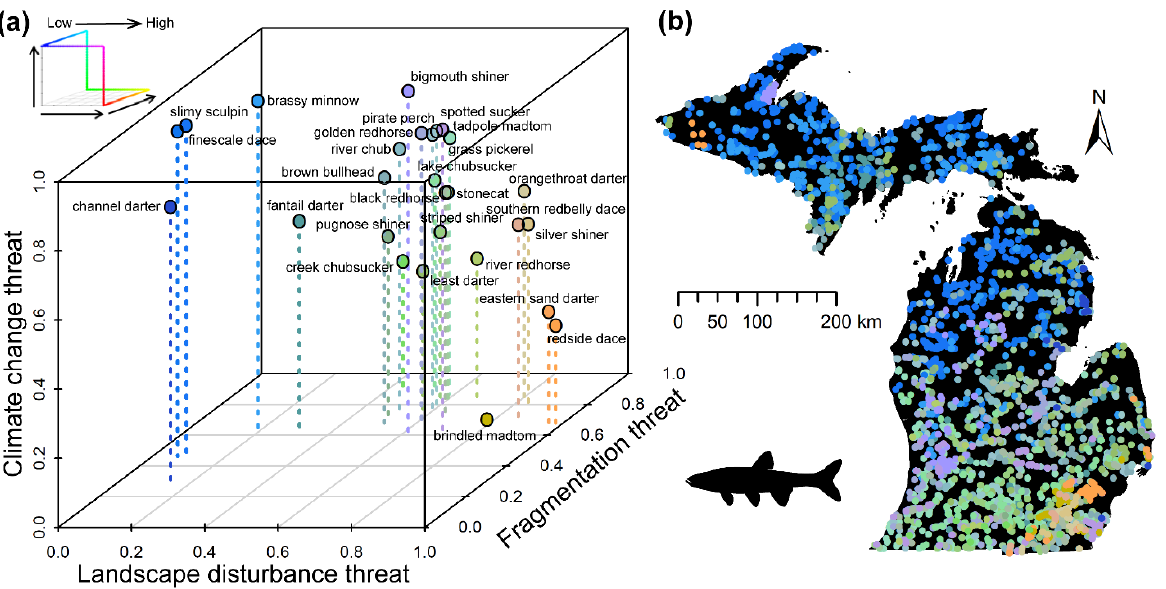
Figure 5. Threats to fish species represented by three threat dimensions: climate change, human landscape disturbance, and fragmentation ( a ) and spatial distribution of known fish occurrences ( b ) colored by composite threat through conversion of threat indices to the Red-Green-Blue (RGB) color system. Note, the study region is displayed in black in ( b ).